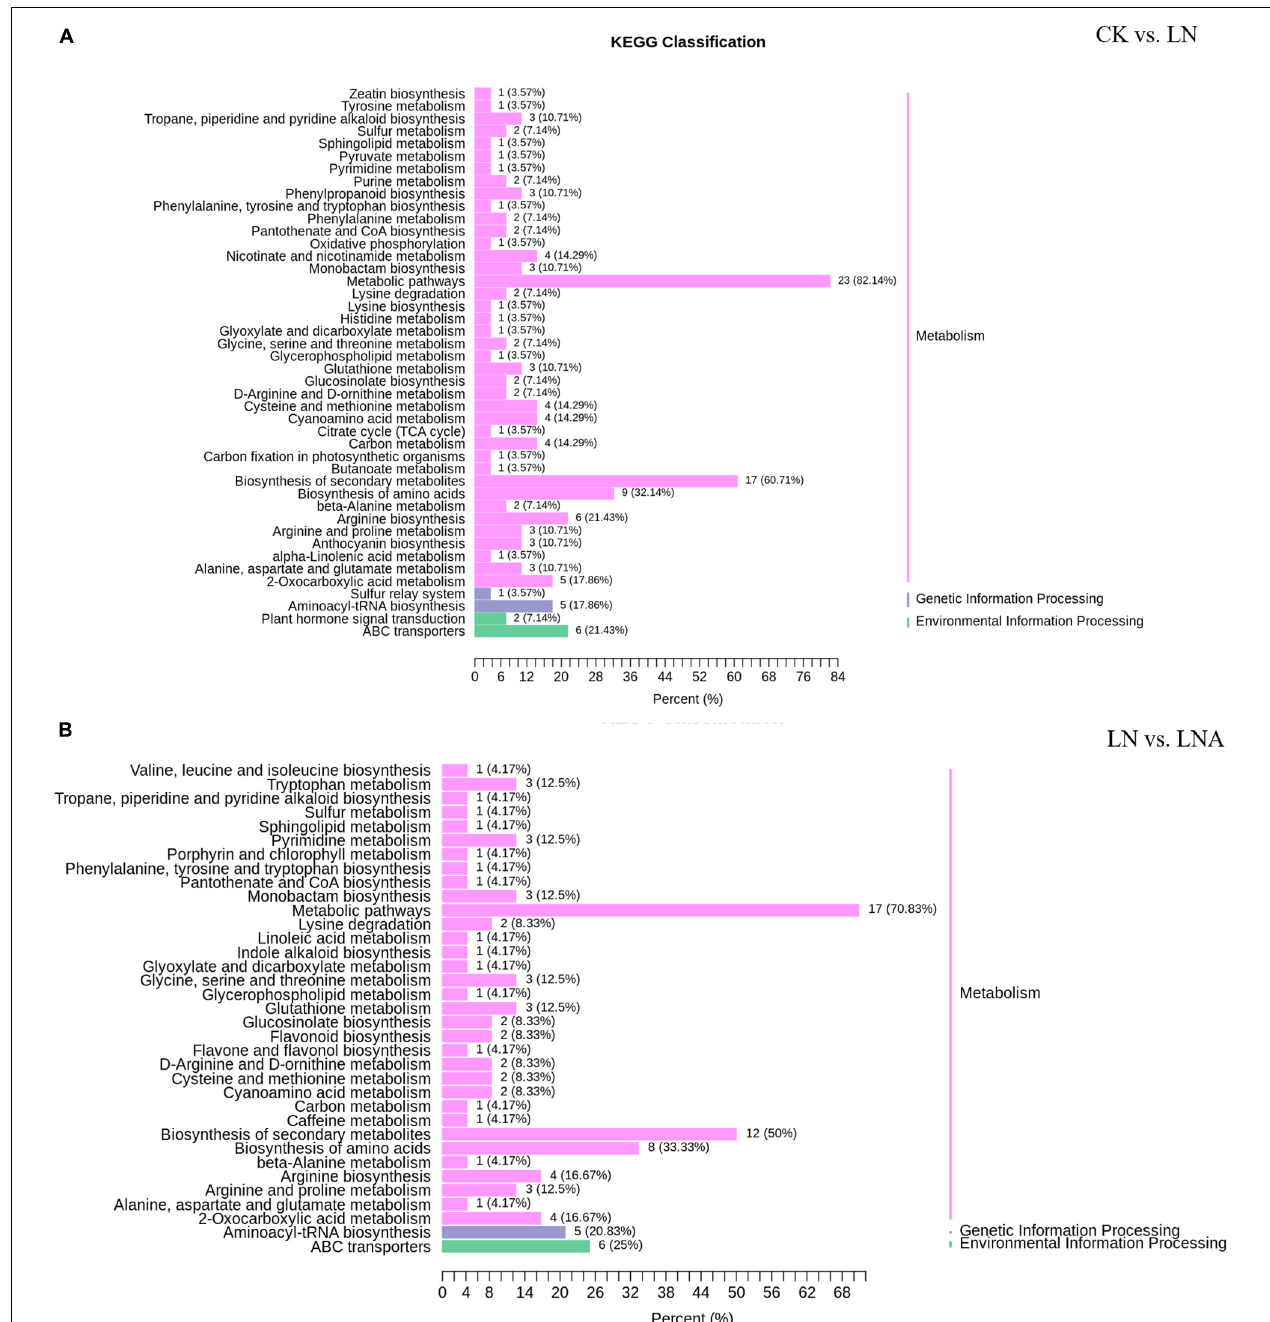
FIGURE 9 | KEGG classification of differential metabolites. CK vs. LN (A) and LN vs. LNA (B) . The ordinate shows the KEGG metabolic pathways, and the abscissa shows the number of metabolites annotated to these pathways and the proportion of the number of metabolites to the total number of metabolites